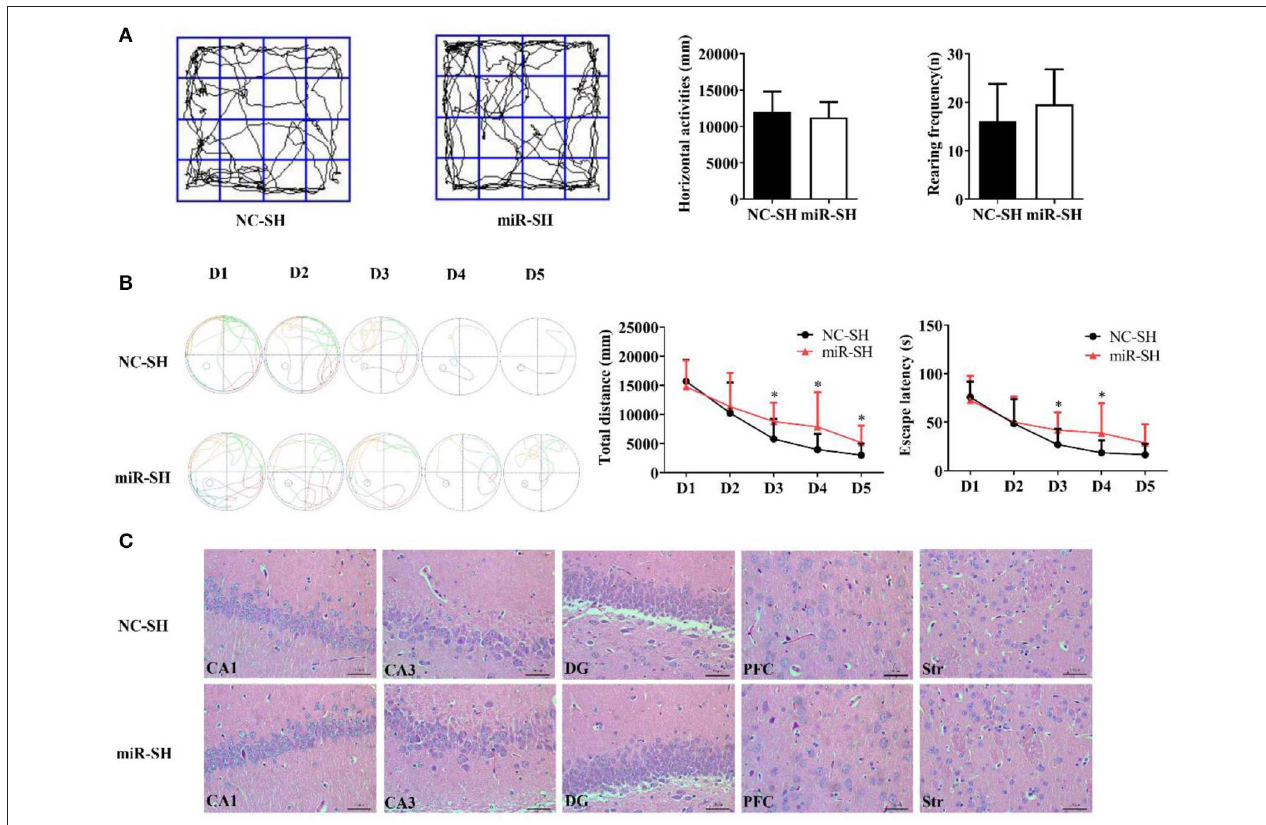
FIGURE 3 | Down-regulation of miR-384-5p impairs learning and memory without causing histological changes in the brain. (A) Path, rearing frequency, and horizontal displacement in the open field test. (B) Path of escape to the platform, total swimming distance, and escape latency in the Morris water maze test. (C) H&E staining of Hip CA1, CA3, and DG, PFC, and Str of miR-SH and NC-SH groups. * P < 0.05.